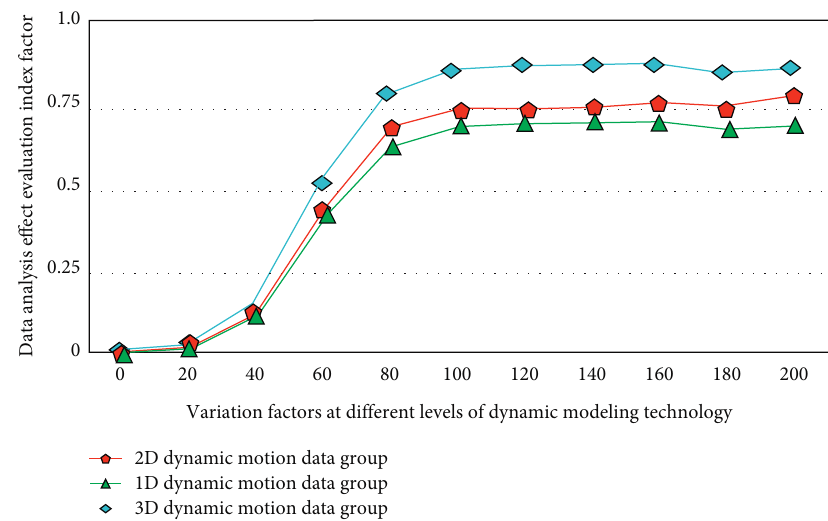
Figure 5: The relationship between different levels of variation factors and effect evaluation index factors.